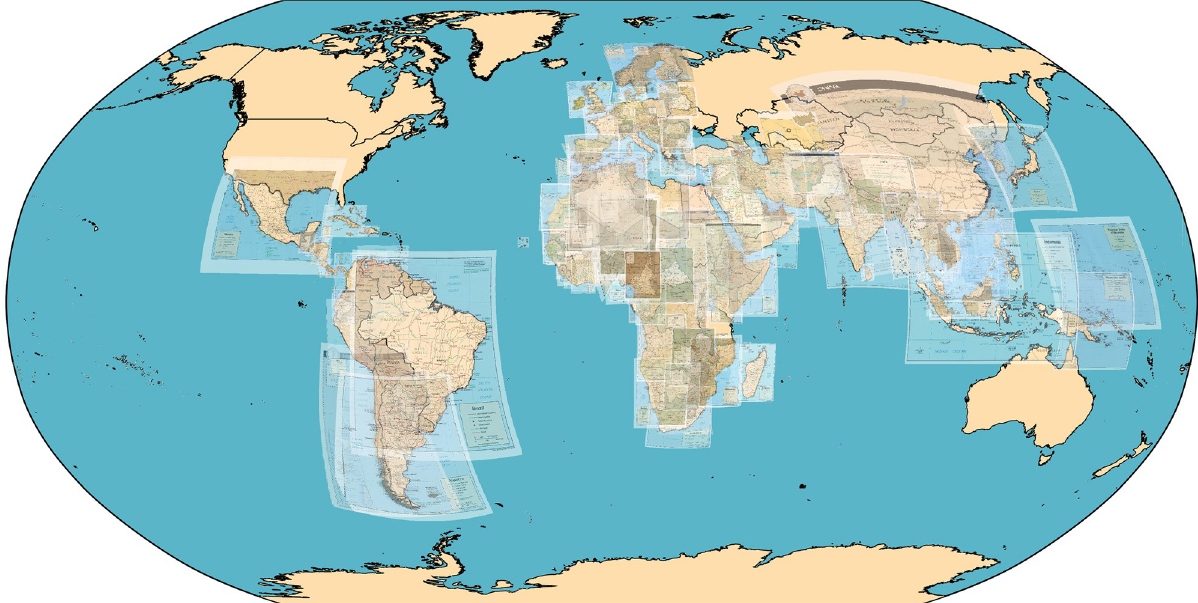
Fig 8. Georeferencing results for real-world country maps. Shows subset of maps with errors less than 5% of map radius, representing about 67% of the total sample. The georeferenced overlay maps are from the University of Texas at Austin’s Perry-Casta ñ eda Library (PCL) Map Collection and are in the public domain. The complete list of all map images and their source URLs can be found in the replication data accompanying this article (see Data Availability statement). The geodata used to render country outlines is from © Natural Earth data and is in the public domain.